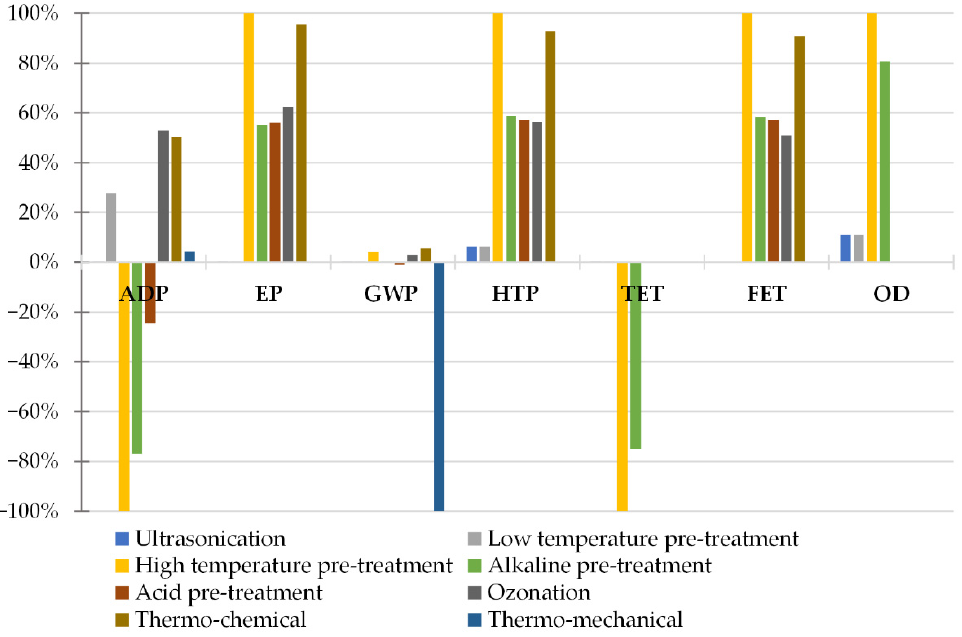
Figure 10. Relative impact of most studied pretreatment technologies, taking the highest absolute value for every category as baseline. ADP: Abiotic Depletion, EP: Eutrophication, GWP: Climate Change, HTTP: Human Toxicity, TET: Terrestrial Ecotoxicity, FET: Freshwater ecotoxicity, OD: Ozone Layer Depletion.